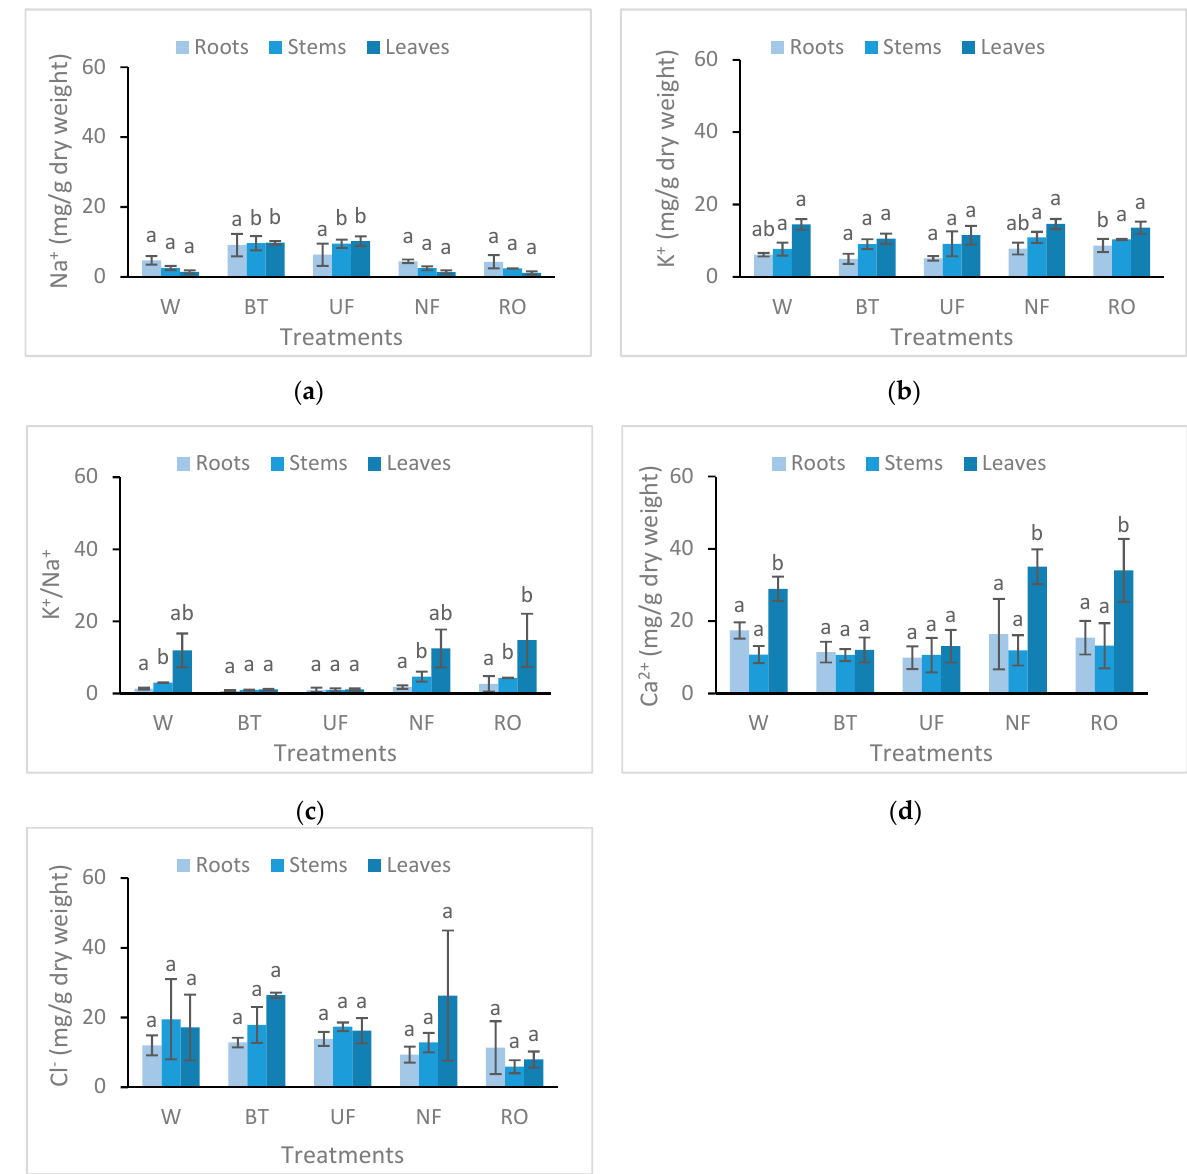
12 of 18 concentrations in the roots (Figure 5a). Beyond 8 dS/m of salt in the soil solution (BT and UF), Sesbania is under saline stress conditions and Na + concentrations increase signi fi - cantly in roots and stems. The aerial parts exhibited the greatest quantity of Na + , which may be a strategy of Sesbania to cope with salt stress [77]. A similar behavior was observed by Hajlaoui et al. [86] in two forage maize ( Zea mays L .). The sequestration of Na + in the vacuole is an important and cost-e ff ective strategy for an osmotic adjustment that reduces cytosolic Na + concentration [87,88]. It protects the cytoplasm, allows the plant to reduce its cellular water potential and, as such, prevents the loss of water [89]. In this present study, K + was mainly in the aerial part of Sesbania (Figure 5b) with unchanged concentrations compared to the reference plants but regardless of the concen- trations in Na + . The same e ff ect was reported in the literature, where the absorption of K + decreases and can even stop with high doses of Na + [86,90,91]. Indeed, K + and Na + ions are always in competition to penetrate plant cells due to their physico-chemical similarity [92,93]. Thus, the K + /Na + selectivity ratio is an index that describes the threshold of toxicity by Na + , a high K + /Na + ratio indicating less Na + toxicity [94,95]. Therefore, we established the K + /Na + selectivity ratio. Our results show that the